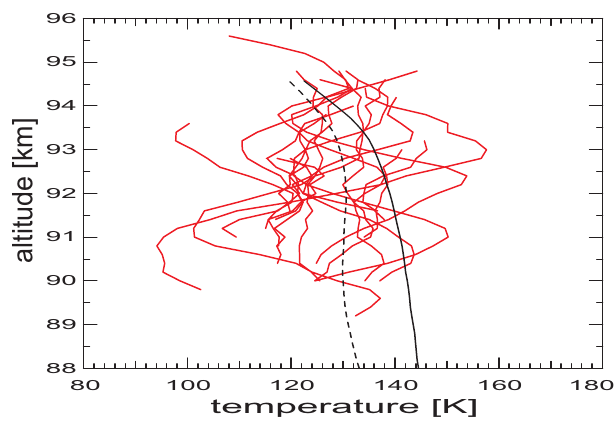
Fig. 2. Single temperature profiles every 15min (red) from 06:42 to 11:26 UT measured by the potassium lidar on 6 July 2003. Dashed black profile correspond to T f with and black solid profile without freeze-drying-effect.